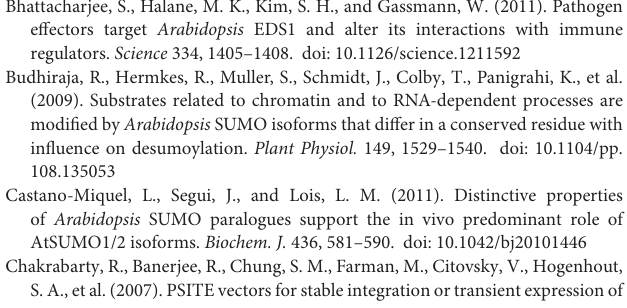
Supplementary Figure 1 | snc1-11 abolishes enhanced SUMO1/2-conjugates and restores elevated SA to Col-0 levels in srfr1-4 . Supplementary Figure 2 | MYB30 is SUMOylated in the E. coli SUMOylation reconstitution system by the T91R variant of SUMO1. Supplementary Figure 3 | A consensus-type and a non-conventional lysine residue in SRFR1 is SUMOylated by SUMO1 in the E. coli SUMOylation reconstitution system. Supplementary Figure 4 | Growth defects of srfr1-4 is abolished by the expression of HA-SRFR1 K325R , HA-SRFR1 K427R , or HA-SRFR1 K325R + K427R variant. Supplementary Figure 5 | EDS1 does not interact with SUMO1 AA or SUMO3 GG/AA. Supplementary Figure 6 | EDS1 SUMOylation is not detected in the E. coli SUMOylation reconstitution system. Supplementary Figure 7 | Enrichment of SUMO1-conjugates from SA-treated plants detect possible SUMOylated EDS1. Supplementary Figure 8 | Over-expression of SUMO1 or SUMO3 in planta does not detect SUMOylated EDS1. Supplementary Figure 9 | GFP-SUM3 overexpressing plants show detectable levels of GFP-SUMO3 proteins. Supplementary Figure 10 | PR1 , PR2 , but not SIZ1 or HPY2 upregulation in esd4-2 plants is SUM3 -dependent. Supplementary Table 1 | List of oligonucleotide